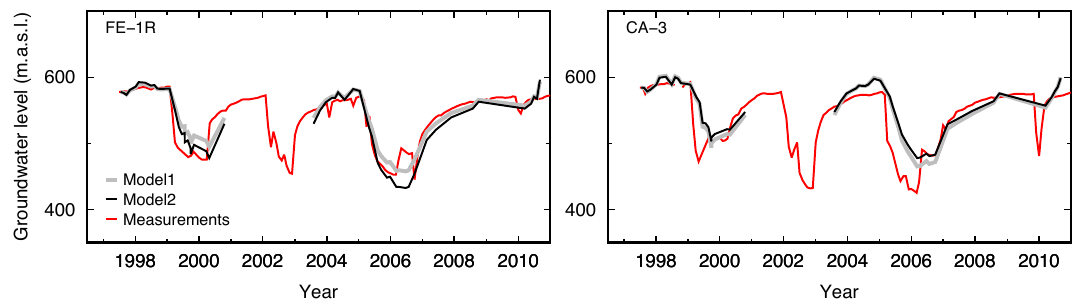
Figure 3. Estimated and measured hydraulic head at two well locations (FE-1R and CA-3). Red line represents measured hydraulic head, gray line represents estimated hydraulic head using the elastic storage coefficient S ke of each well and black line represents estimated hydraulic head using the average elastic storage coefficient S ke computed from all 19 wells labelled in Fig.